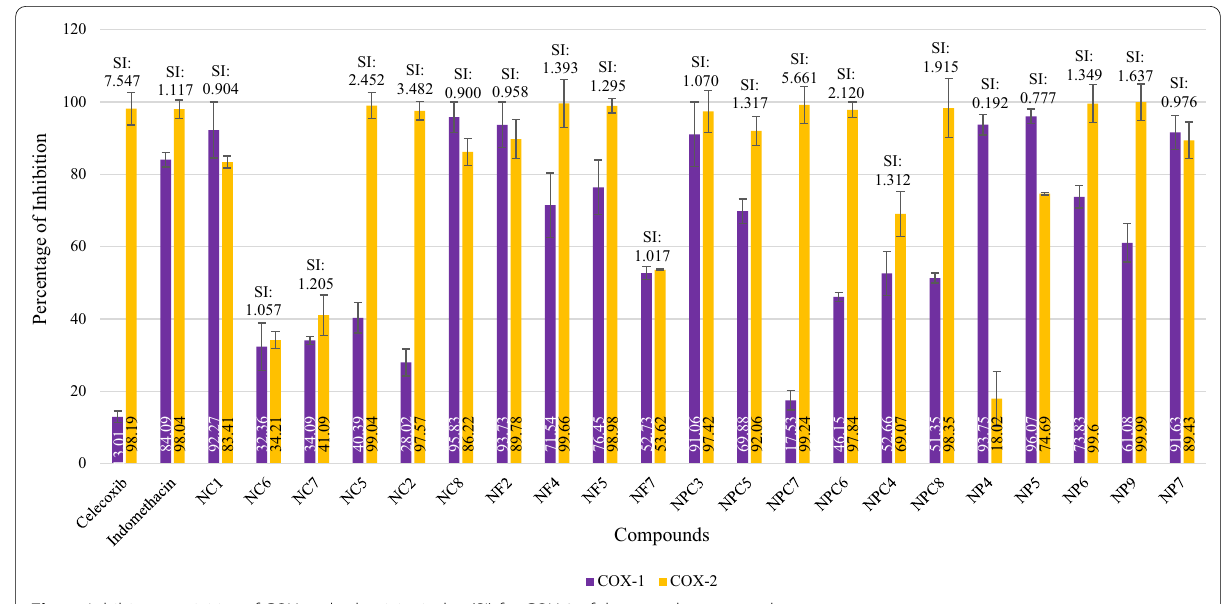
Fig. 1 Inhibitory activities of COX and selectivity index (SI) for COX-2 of the tested compounds